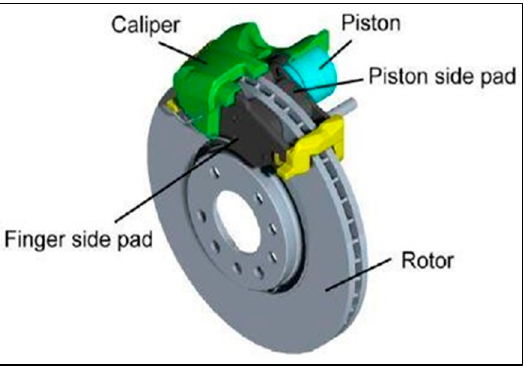
Figure 1. Typical disc brake used in modern vehicles [8].